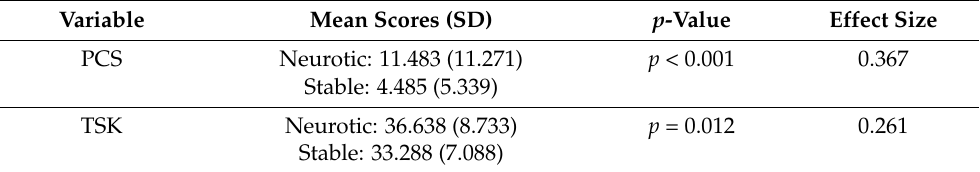
Table 3. Independent samples test for neurotic vs. stable sttributes.